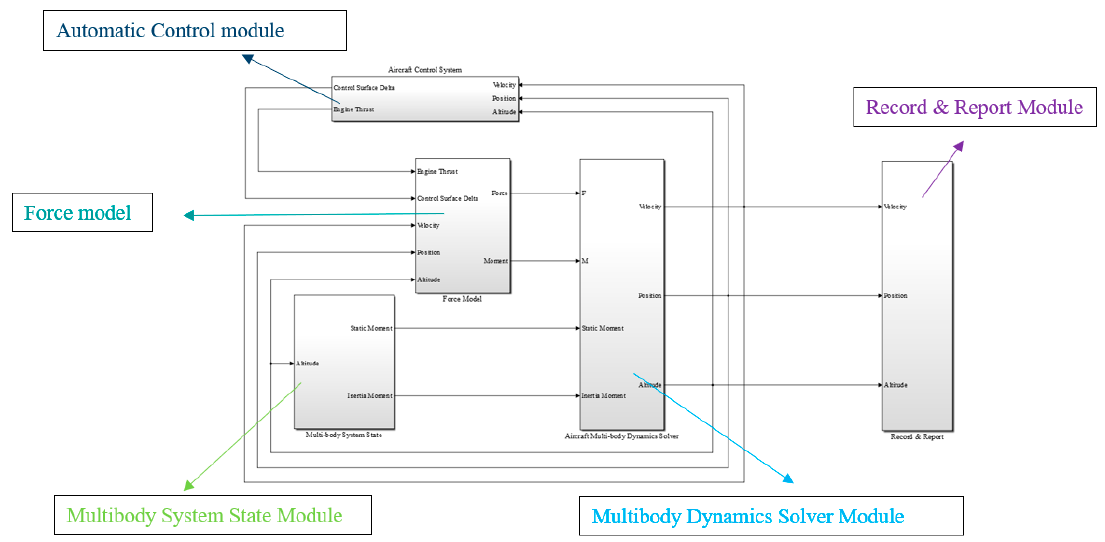
Figure 8. MATLAB / Simulink simulation platform. Figure 8. MATLAB/Simulink simulation platform.